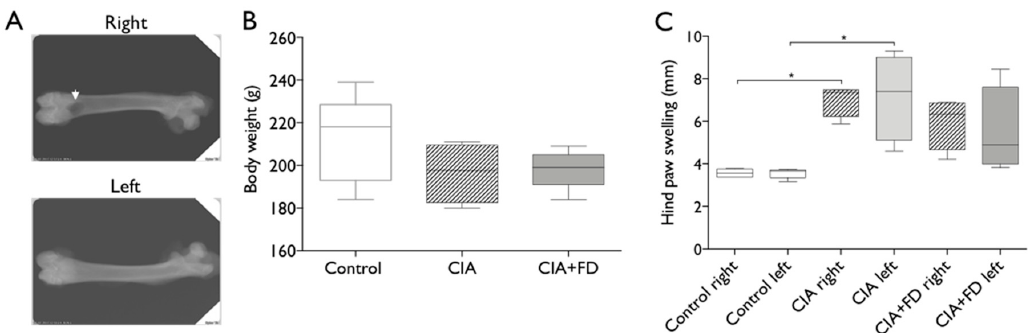
Figure 1. Combination of collagen-induced arthritis (CIA) model with femoral defect (FD). CIA was induced and allowed to develop for 21 days, before a cylindrical defect was performed in the femur of a half of the CIA animals to combine both animal models (CIA + FD) ( A ) X-ray of cylindrical defect performed on the right femur (white arrow indicates the defect site) of CIA animals at day 3 after surgery. ( B ) Body weight evaluation 3 days after bone defect. ( C ) Measurements of paw swelling in both paws (right and left) of control, CIA and CIA + FD, 3 days after bone injury. Box plots represent min-to-max distribution of n = 4 to 5 animals per group. * p < 0.05, determined by Kruskal–Wallis test and Dunn’s multiple comparisons test.